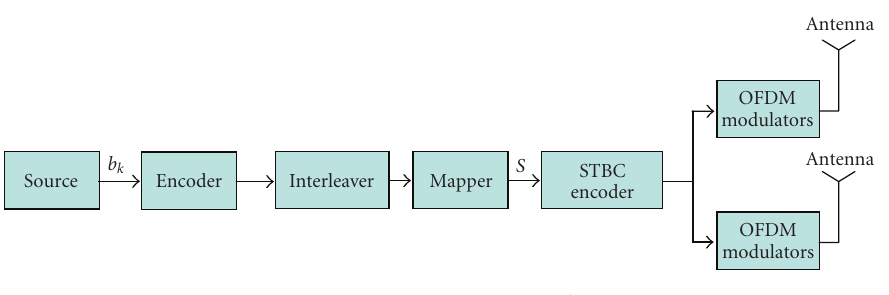
Figure 3: MIMO-OFDM